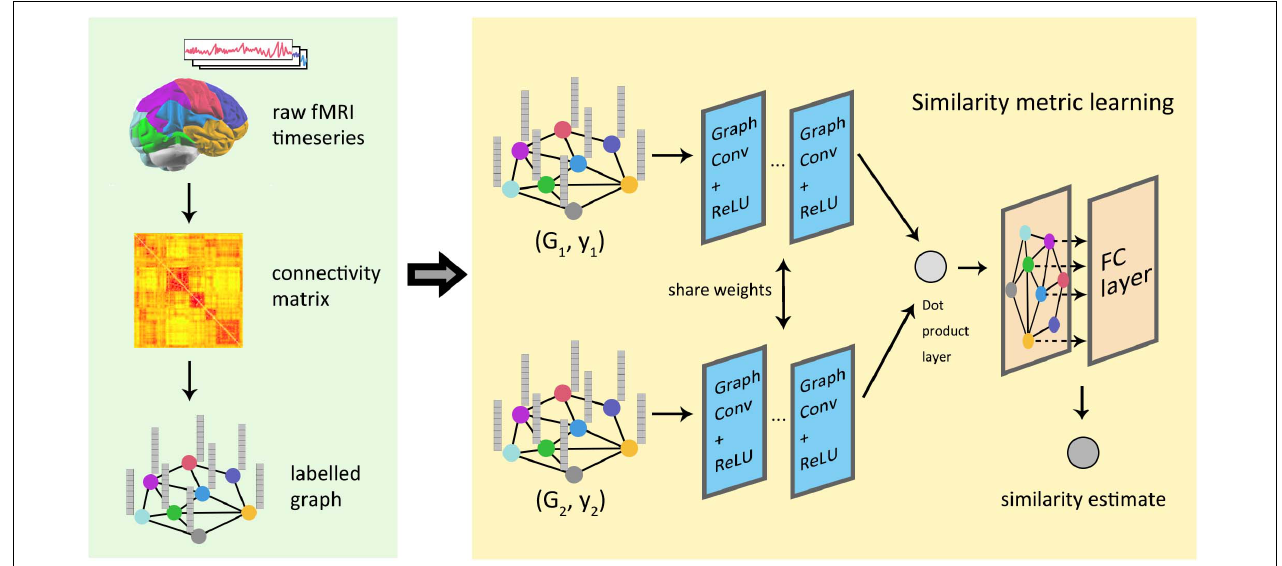
FIGURE 9 | Similarity measure learning of graph neural network in functional brain graphs. The information contained in the fMRI image was integrated into the graph through the graph partition and connection matrix. Two graphs were, respectively, used as the input of the two graph convolutional networks with sharing parameters, and the output of the network was combined by the inner product layer. Finally, a fully connected layer outputs the estimated similarity between the graphs.